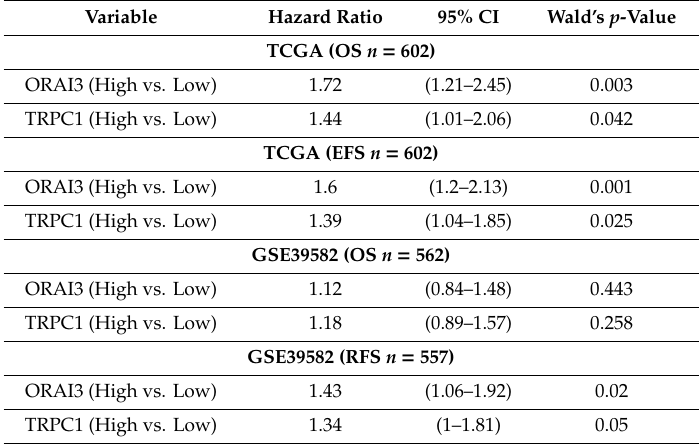
Table 1. Univariate analysis of genes correlated with survival in TCGA and GSE39582.